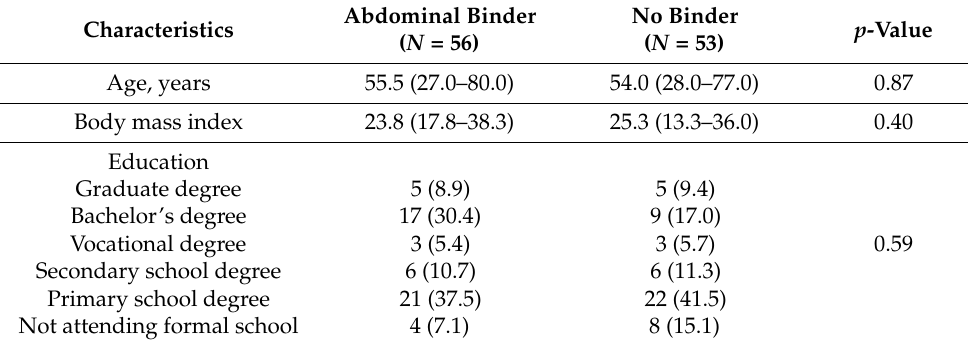
Figure 1. CONSORT flow diagram. Table 1. Baseline clinical and surgical